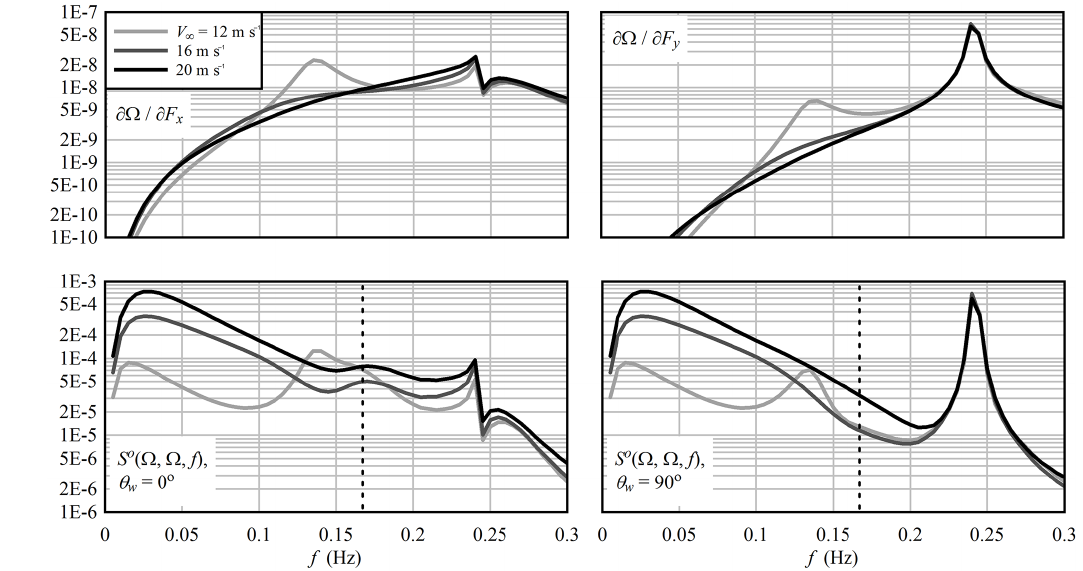
Figure 14. Transfer functions (above) of waterline wave forces to rotor speed and spectra (below) for a wave state of H s = 2m, T p = 6s. On the left: wind and waves aligned. On the right: waves orthogonal to wind. The dashed line indicates the peak in the wave elevation